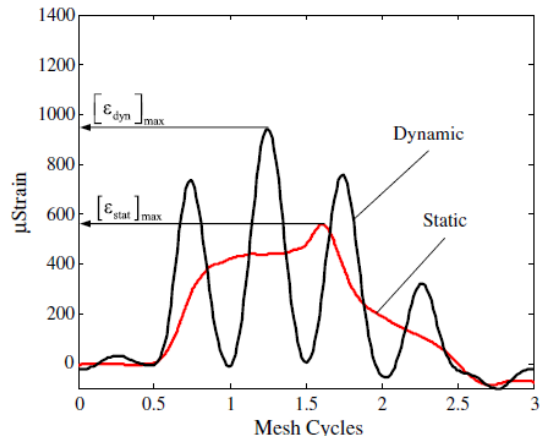
Figure 12. Static and dynamic tooth root strains during engagement from